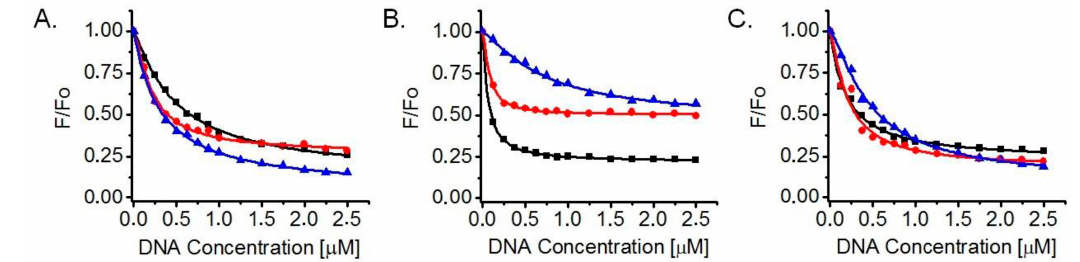
Figure 3. Normalized fluorescence maxima vs. G-quadruplex DNA concentration during fluorescence titrations of ligands 10 (blue triangles), 13 (red circles) and 14 (black squares) with 22AG/K + ( A ); 22AG/Na + ( B ); and Myc2345-Pu22/K + ( C ). Ligand and DNA solutions were prepared in 10 mM lithium cacodylate buffer (pH 7.2), with the monovalent cation at 100 mM concentration. Table 1. Dissociation constant (K D , in M − 1 ) values and number of binding sites ( n ), as determined by nonlinear curve fitting (growth-sigmoidal/Hill 1, no weights, fixed starting point) of fluorescence titrations data. In all cases, adjusted R 2 was ≥ 0.995.